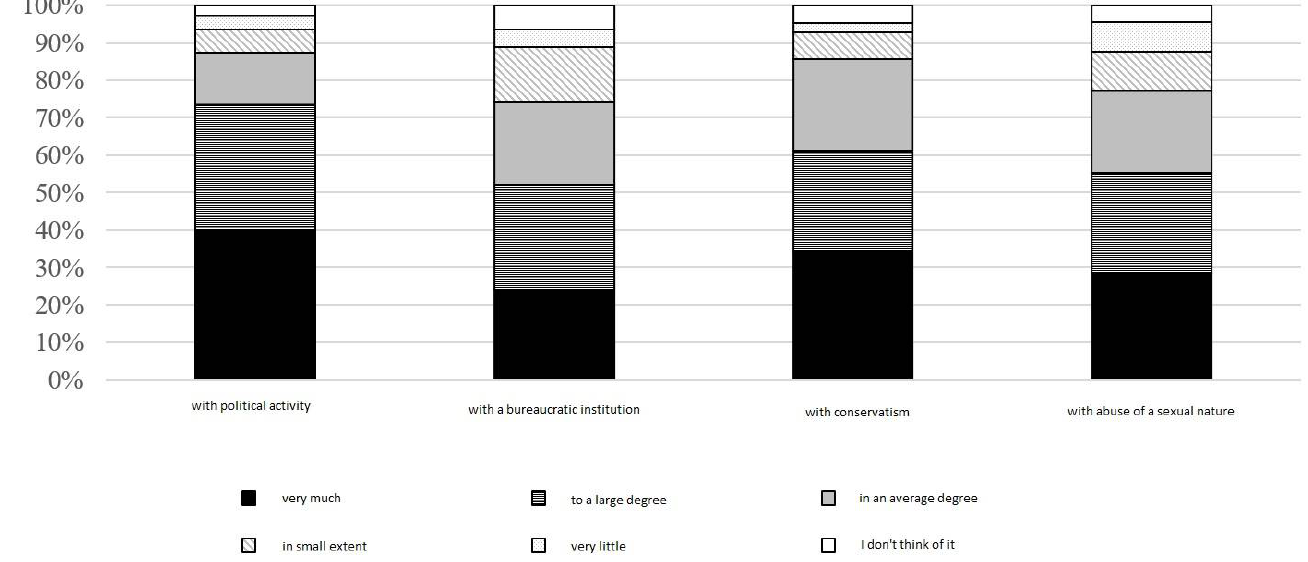
Figure 5. Negative associations with the Catholic Church in Poland. Source: authors’ own elaboration.